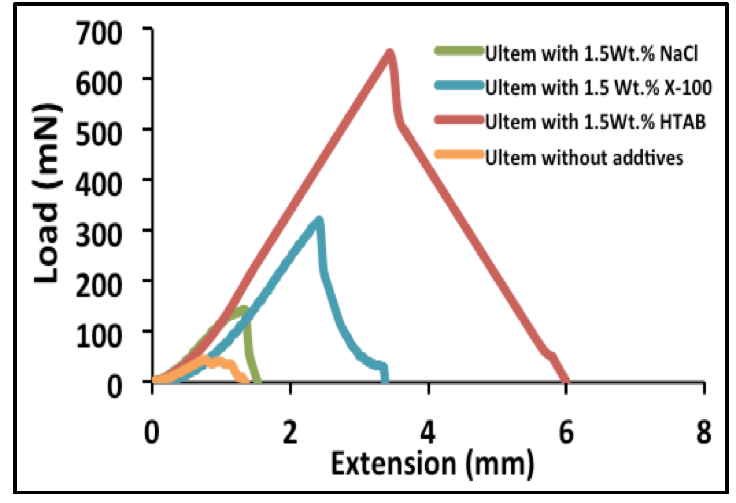
Figure 9. Tensile properties of pure PEI fiber mats and with addition different surfactants.